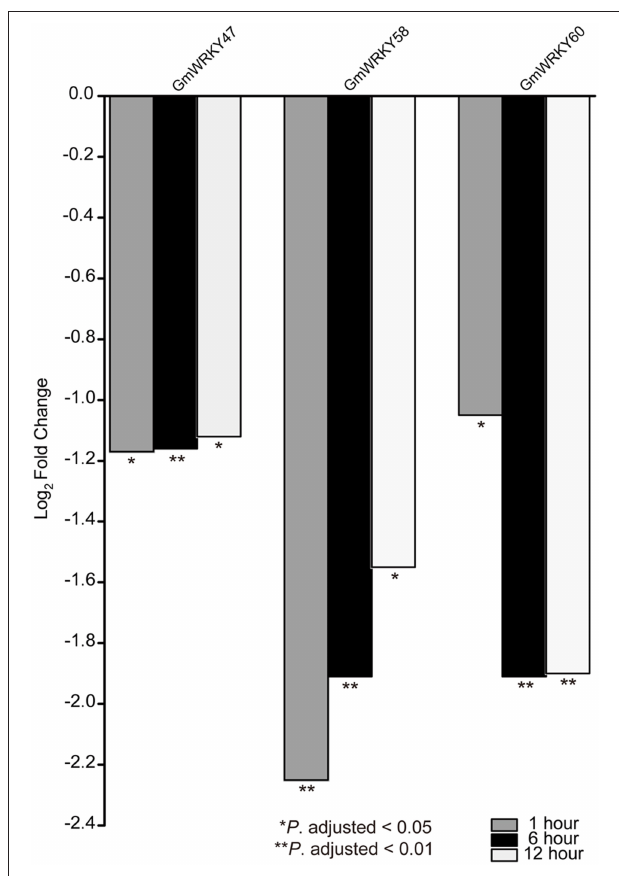
FIGURE 8 | Different expression of GmWRKY genes in three time point under dehydration stress based on RNA-seq data.